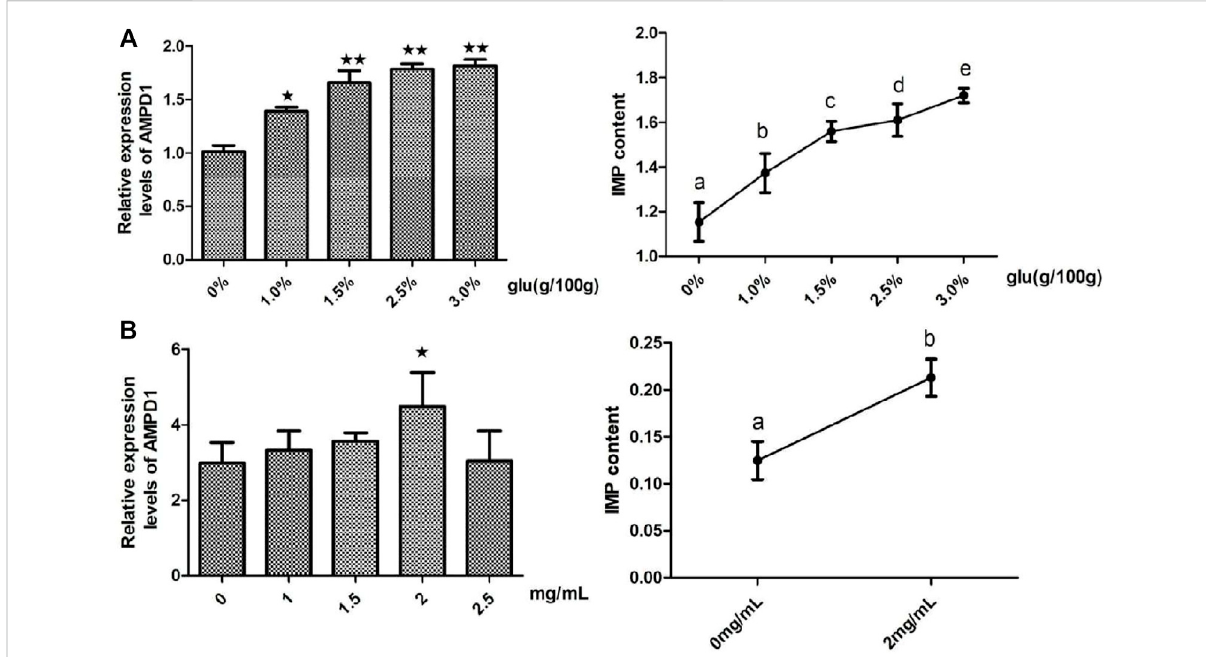
FIGURE 5 Effects of glutamate (Glu) on the relative mRNA expression of AMPD1 and the IMP content in vivo (A) and in vitro (B) . Error bars represent the means ± SD; n = 3. p < 0.05.